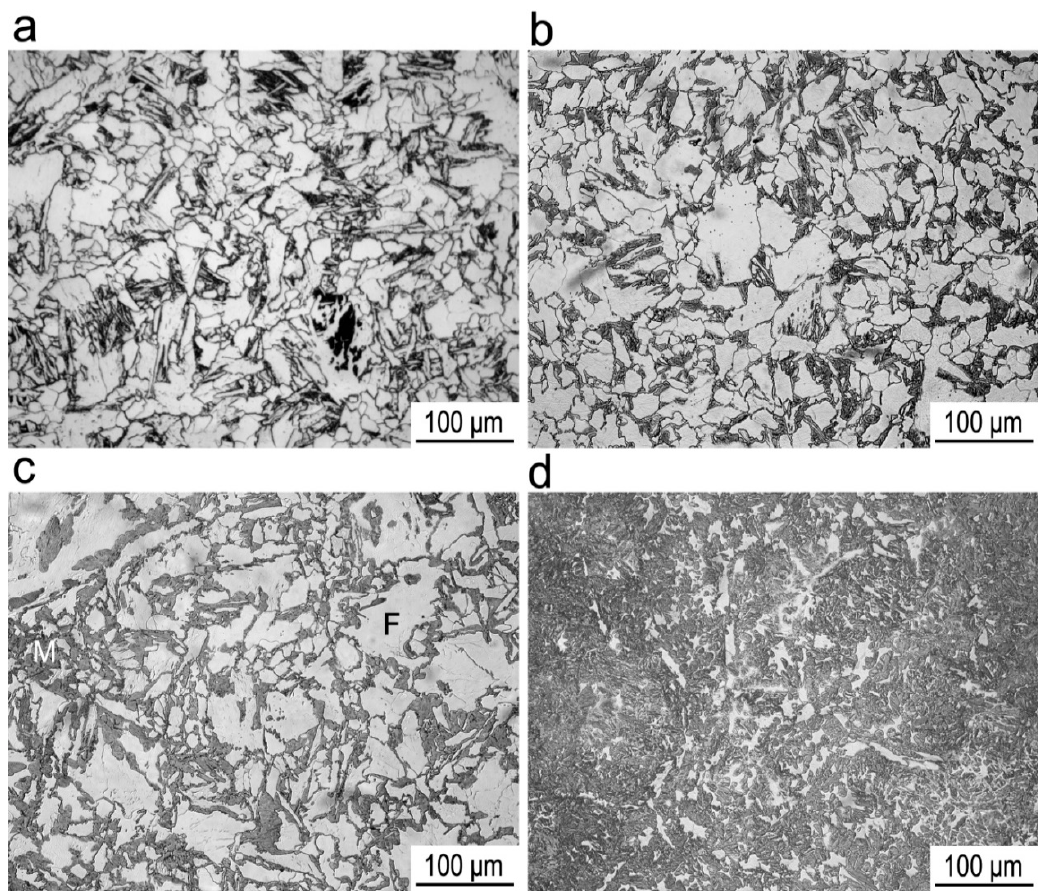
Figure 6. OM microstructures after intercritical annealing at ( a ) 750 °C for 120 s, ( b ) 750 °C for 180 s,